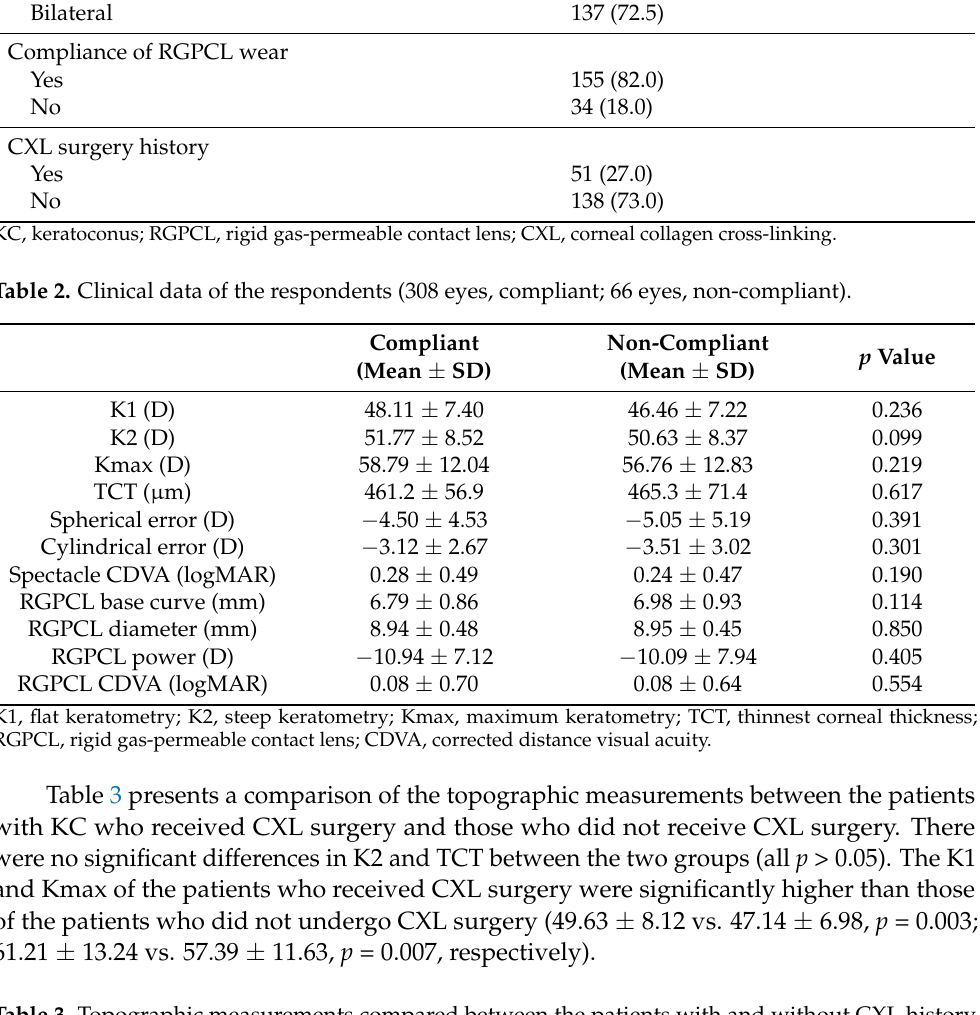
Table 3. Topographic measurements compared between the patients with and without CXL history (102 eyes, with CXL history; 272 eyes, without CXL